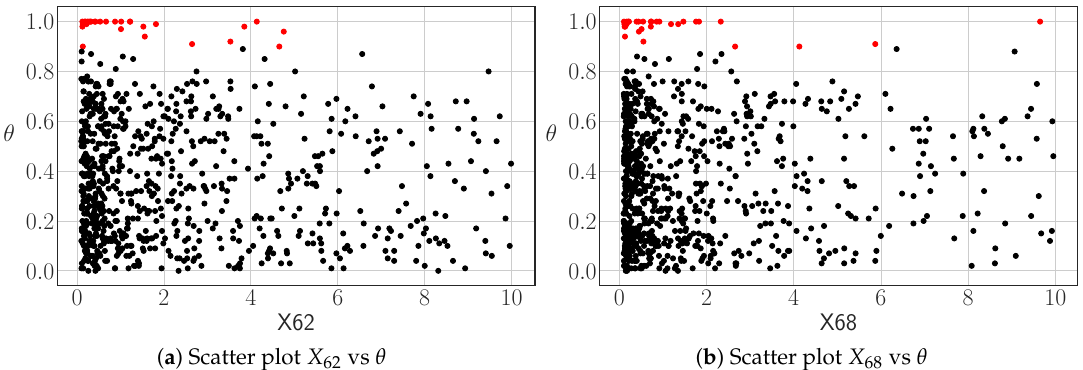
Figure 4. Scatter plots of two input variables of CATHARE2 and the outlyingness score θ . The points correspond to the bivariate plot of the values of the selected variable and the corresponding θ . The red dots correspond to the simulations that have been retained as